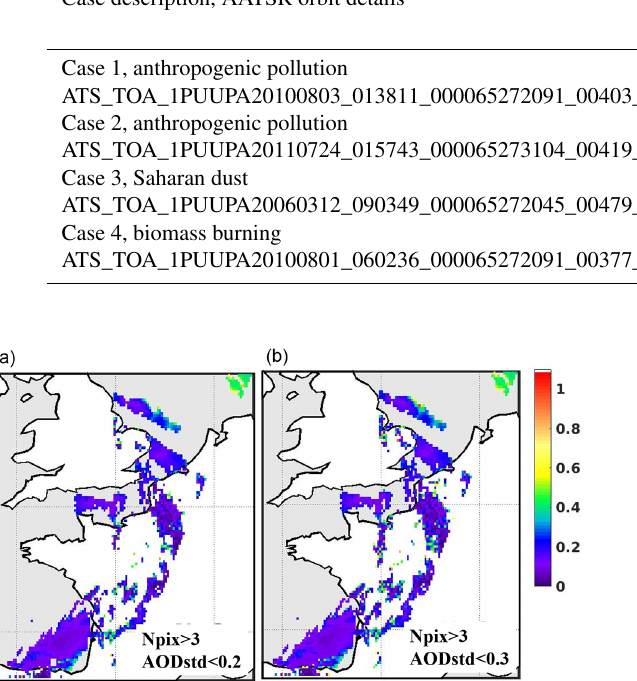
Figure 7. Example of the visual inspection of the AOD spatial dis- tribution for the overpass on 29th July 2008, ca. 10:00UTC (as in Figs. 1–3) for AODstd<0.2 (a) and AODstd<0.3 (b)